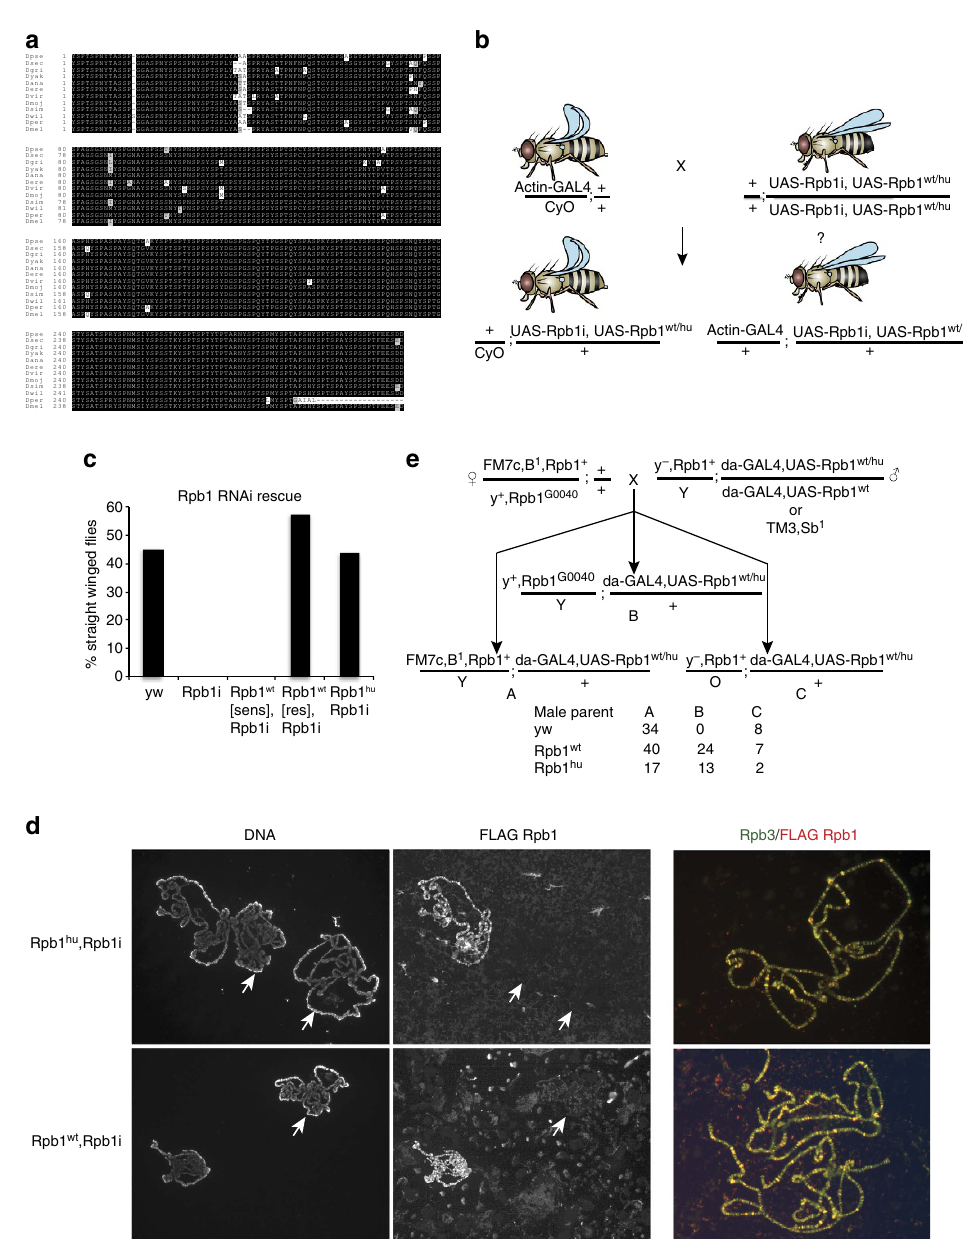
Figure 7 | The human CTD can function in place of the Drosophila CTD in vivo . ( a ) CTD amino acid sequence alignment from 12 species of Drosophila . ( b ) Experimental design of the human CTD rescue experiment. UAS-Rpb1i is a GAL4 inducible transgene that produces an RNAi against endogenous Rpb1. UAS-Rpb1 is a GAL4 inducible transgene that encodes a FLAG-tagged, RNAi-resistant derivative of Rpb1. Fly images were created with Genotype Builder 54 , ( c ) Results of crosses to test if ectopically expressed derivatives of Rpb1 rescue the lethality caused by ubiquitously expressing Rpb1 RNAi. Each bar on the histogram indicates the percentage of progeny with straight wings. yw : ActGAL4/CyO (cid:3) yw ( n ¼ 137 progeny); Rpb1i: ActGAL4/CyO (cid:3) UAS- Rpb1i ( n ¼ 86 progeny); Rpb1 wt [sens],Rpb1i: ActGAL4/CyO (cid:3) UAS- Rpb1i,UAS-Rpb1 sen ( n ¼ 102 progeny); Rpb1 wt [res],Rpb1i: ActGAL4/CyO (cid:3) UAS- Rpb1i,UAS-Rpb1 res ( n ¼ 91 progeny); Rpb1 hu ,Rpb1i: ActGAL4/CyO (cid:3) UAS- Rpb1i, UAS-Rpb1 hu ( n ¼ 78 progeny). ( d ) Immunofluorescence of polytene chromosomes from salivary glands of third instar larvae. Larvae were derived from mating ActGAL4/CyO and UAS-Rpb1i, UAS-Rpb1 parents, so half of the larvae ectopically expressed Drosophila or humanized Rpb1 (Left and Middle panels). FLAG Rpb1 detected on chromosomes co-localizes with the Rpb3 subunit of Pol II (Right panel). Arrows highlight chromosomes from individuals not expressing FLAG Rpb1 variants ( CyO/ þ ; UAS-Rpb1i,UAS-Rpb1/ þ ). ( e ) Genetic complementation assay mating scheme and results. Complementation was scored in males, which have a single copy of the X chromosome on which the endogenous Rpb1 gene resides. Female flies carrying the early embryonic lethal Rpb1 mutant allele, G0040 are crossed to male flies expressing Rpb1 wt or Rpb1 hu under the control of da-GAL4, or to yw control flies. Crosses were carried out in triplicate with 8 males and 8 female parents per cross and flies were grown at 24C and 70% humidity. Shown in e are the total counts of male progeny; counts from individual vials are shown in Supplementary Table 1. ‘B’ males indicate that the ectopically expressed Rpb1 complements of the lethal allele. We observe no ‘B’ flies from the yw control